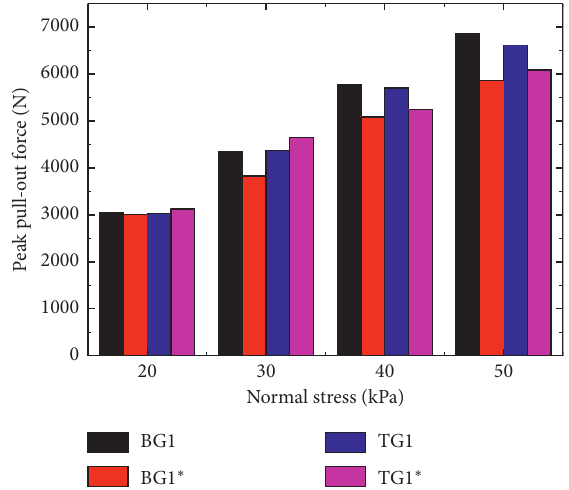
Figure 12: Comparison of peak pull-out force with and without node